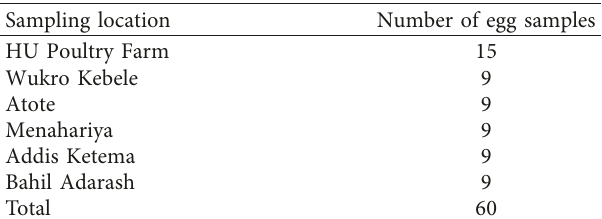
Table 1: Sampling locations and sample size of shell eggs con- sidered in the study of microbial profile and safety in Hawassa City, southern